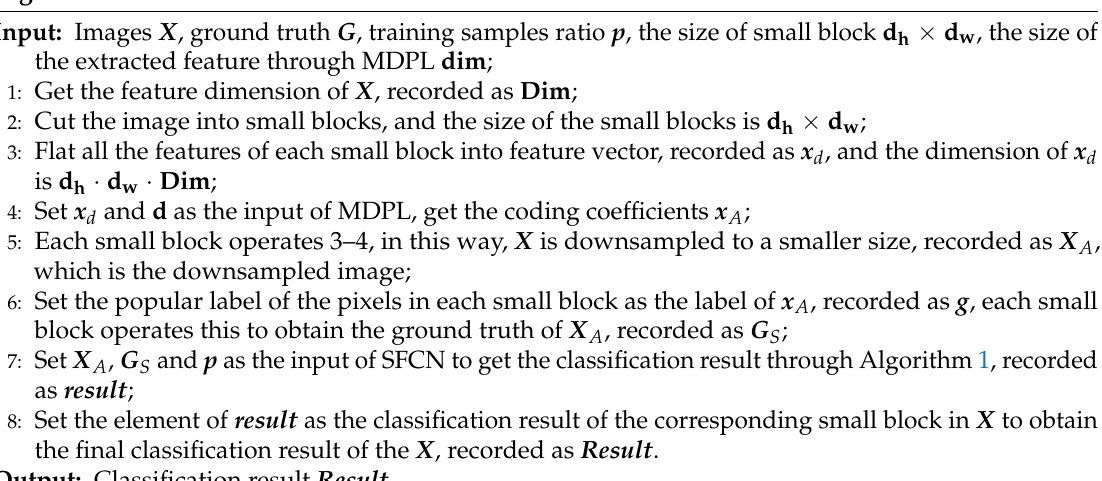
Figure 3. The architecture of SFCN-SC. First, the input image is cut into small blocks, and the size of each small block is d h × d w . Then, all the features of each small block are flatted into feature vector, and the dimension of each feature vector in the input image is d h · d w · Dim . Second, each feature vector is set as the input of sparse coding to get the coding coefficients, and the dimension of each coding coefficients is dim . In this way, the input image is downsampled to a smaller size. That is to say, a small block in the input image corresponds to a pixel in the downsampled image. Third, the downsampled image is set as the input of SFCN to obtain the classification result. Finally, the classification result of the pixel in the downsampled image is regarded as the classification result of the corresponding small block in the input image. In this way, the final classification result can be obtained. Algorithm 2 The framework of